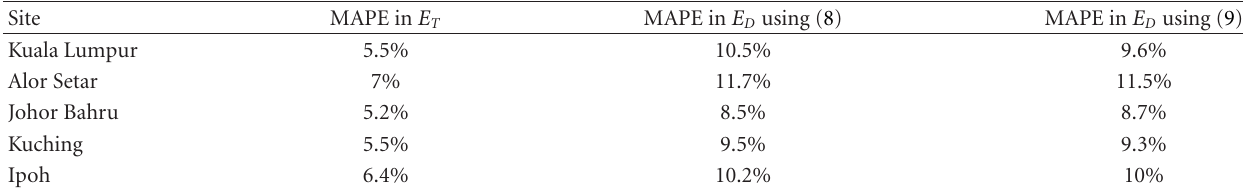
Table 4: MAPE in global and di ff used solar